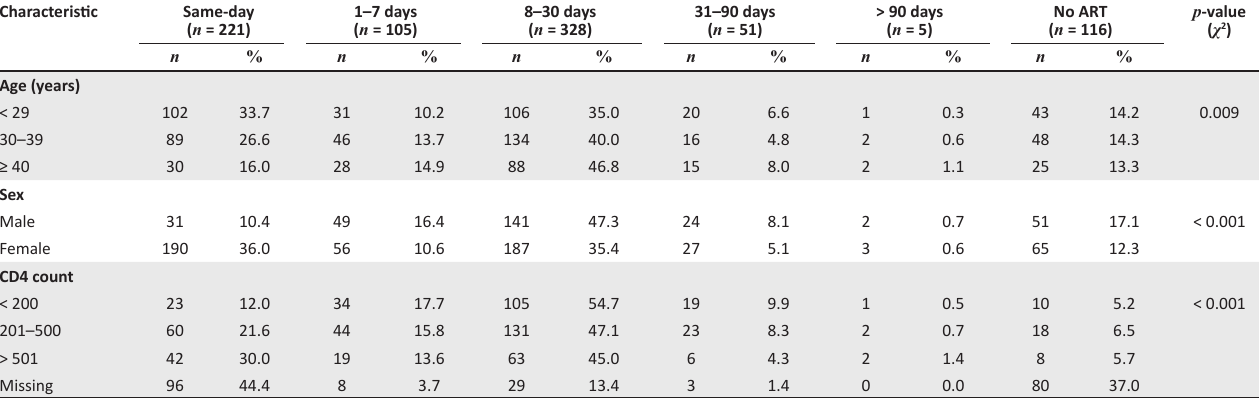
TABLE 2: Timing of antiretroviral therapy initiation.